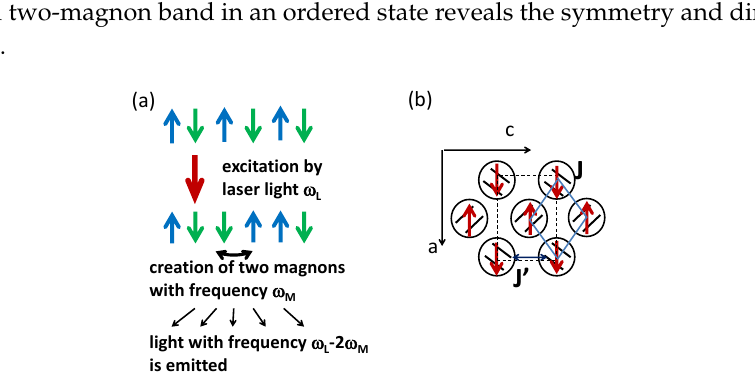
Figure 1. ( a ) A scheme of excitation of pairs of magnons in an antiferromagnetic chain; ( b ) A schematic view of a structure of BEDT-TTF-layer of a κ -phase crystal as a model of S = 1/2 sites on a frustrated square